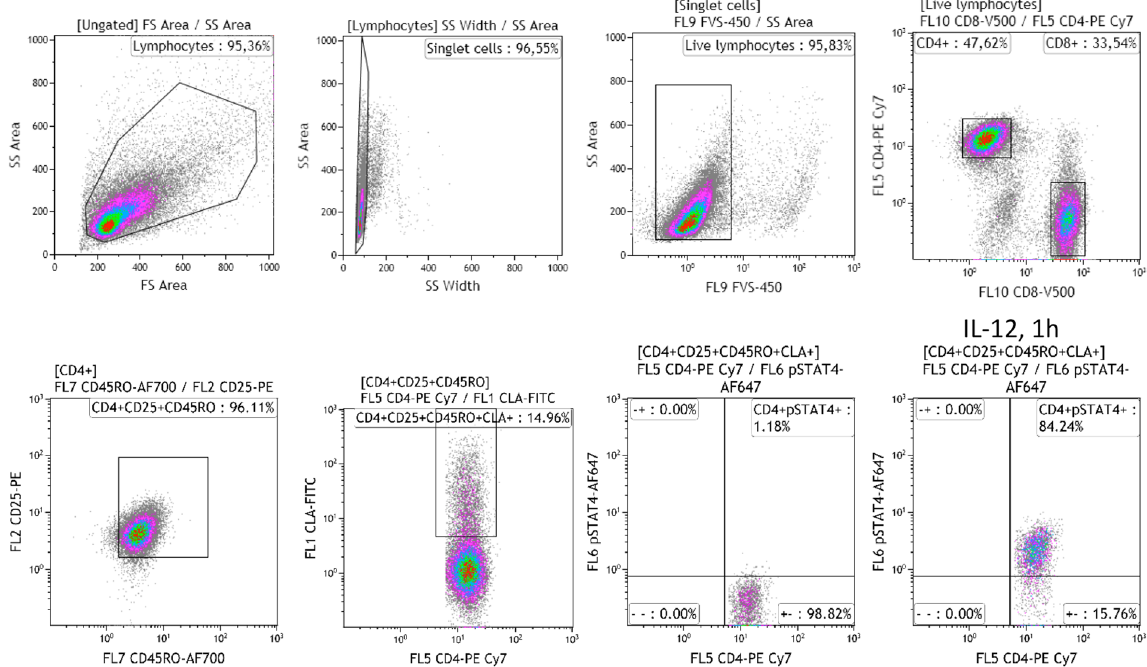
Figure 2. Gating strategy for phospho-flow cytometry of p-STAT4. Lymphocytes were gated on a forward (FS) and side scatter (SS) density plot and on a SS area versus SS width density plot to remove doublet cells. A live/ dead stain (FVS-450) was used to exclude dead lymphocytes. Live, activated, memory, skin-homing CD4 + or CD8 + T lymphocytes were selected based on the expression of CD25, CD45RO, and cutaneous lymphocyte antigen (CLA). pSTAT4 expression was detected in cells activated by anti-CD3/CD28 and stimulated with or without 50 ng/ml IL-12 for 1